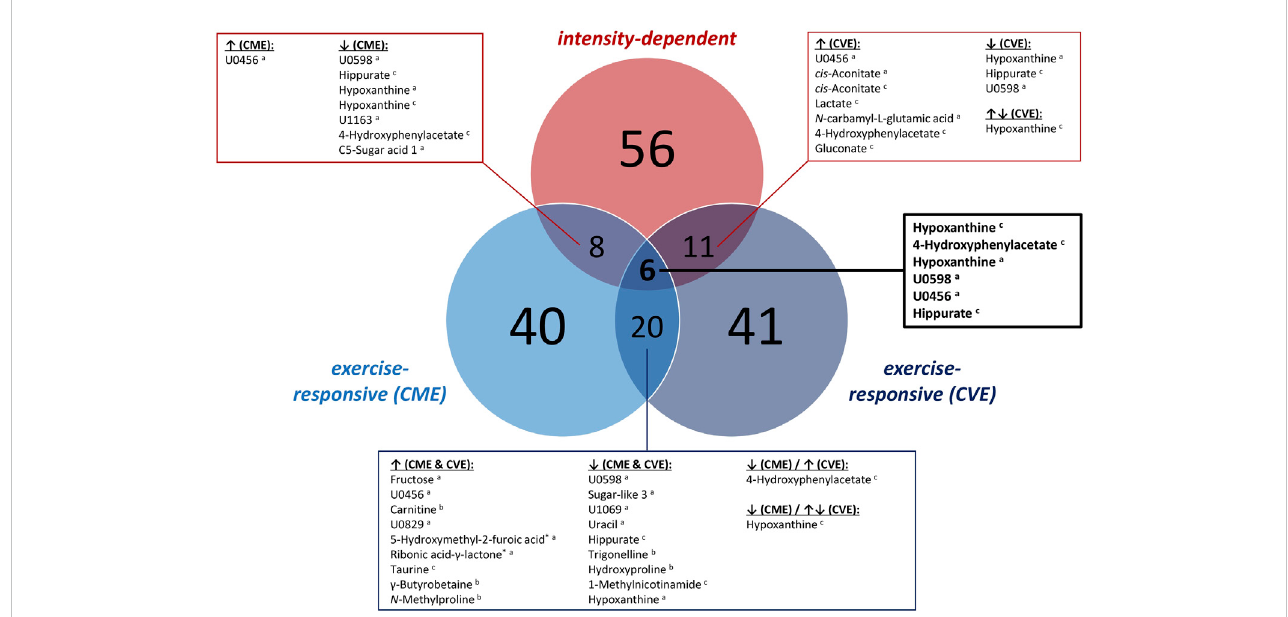
FIGURE 5 Venn diagram summarizing the number of exercise-responsive as well as intensity-dependent urinary metabolites. a : GC×GC-MS-detected; b : LC-MS- detected; c : NMR-detected; *: relevant metabolites based on heuristic/visual approach; U: unknown